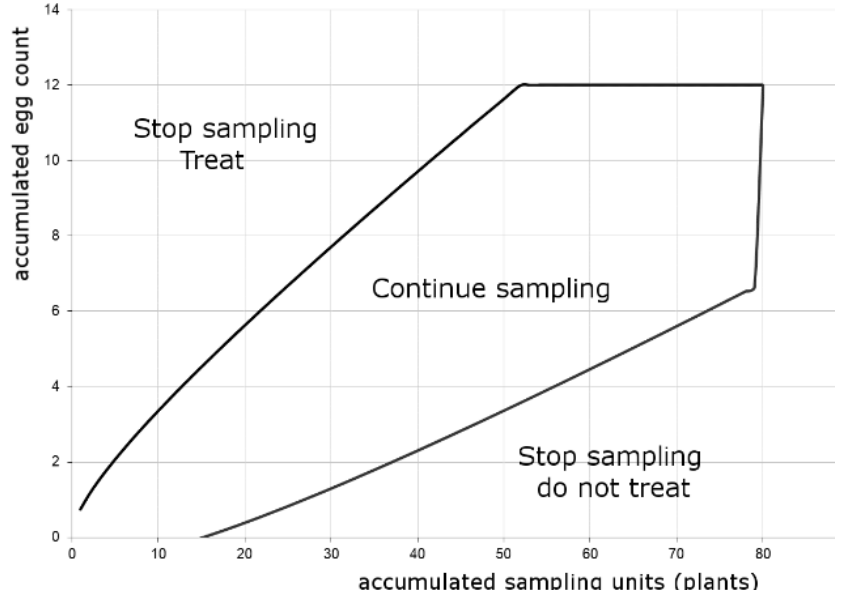
Figure 3. Acceptance curves (stop boundaries) of the sequential sampling plan for Helicoverpa armigera eggs according to Iwao’s method (based on the TPL regression with 105 data sets—model values in Table 4; α = 0.20, β = 0.10; n min = 20, n max = 80, σ = 0.16); the boundaries were calculated using crop protection decision-making Mathcad worksheets of the electronic version of Binns et al. [45].